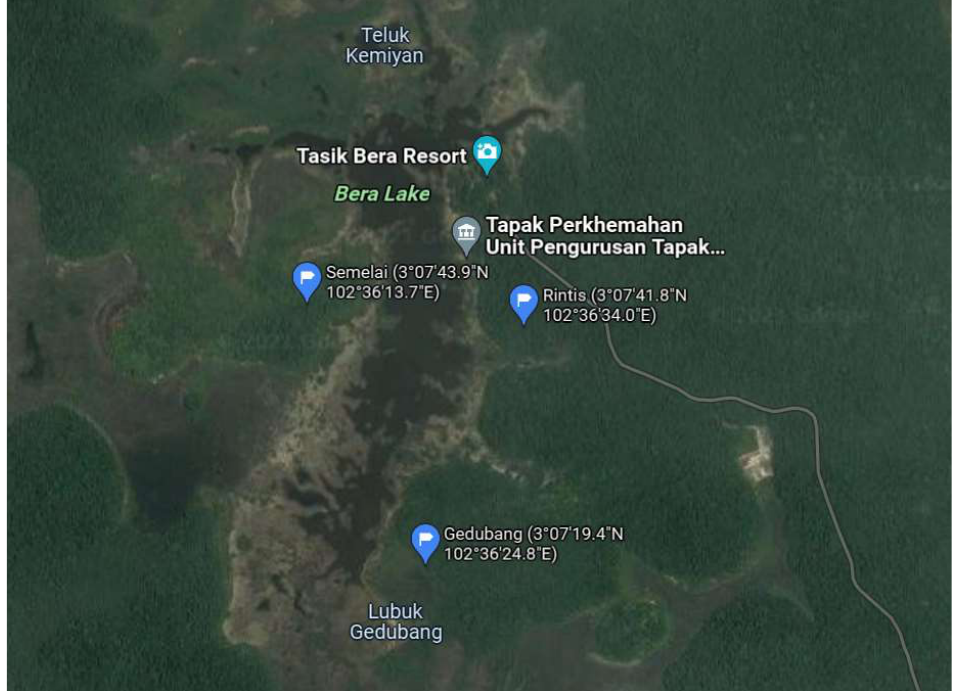
Figure 1. Sampling site of Bera Lake Forest located in Pahang, Malaysia. The coordinate of the sampling site is 3°07′41.8″ N 102°36′34.0″ E.